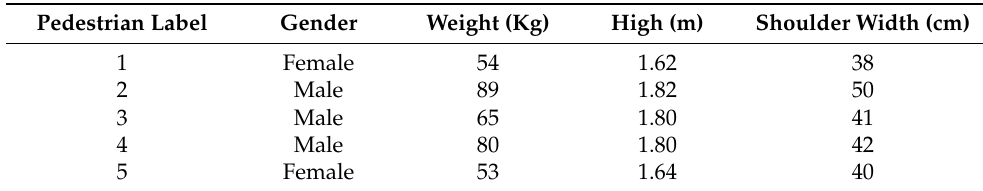
Table 3. The experimental pedestrian parameters. Pedestrian